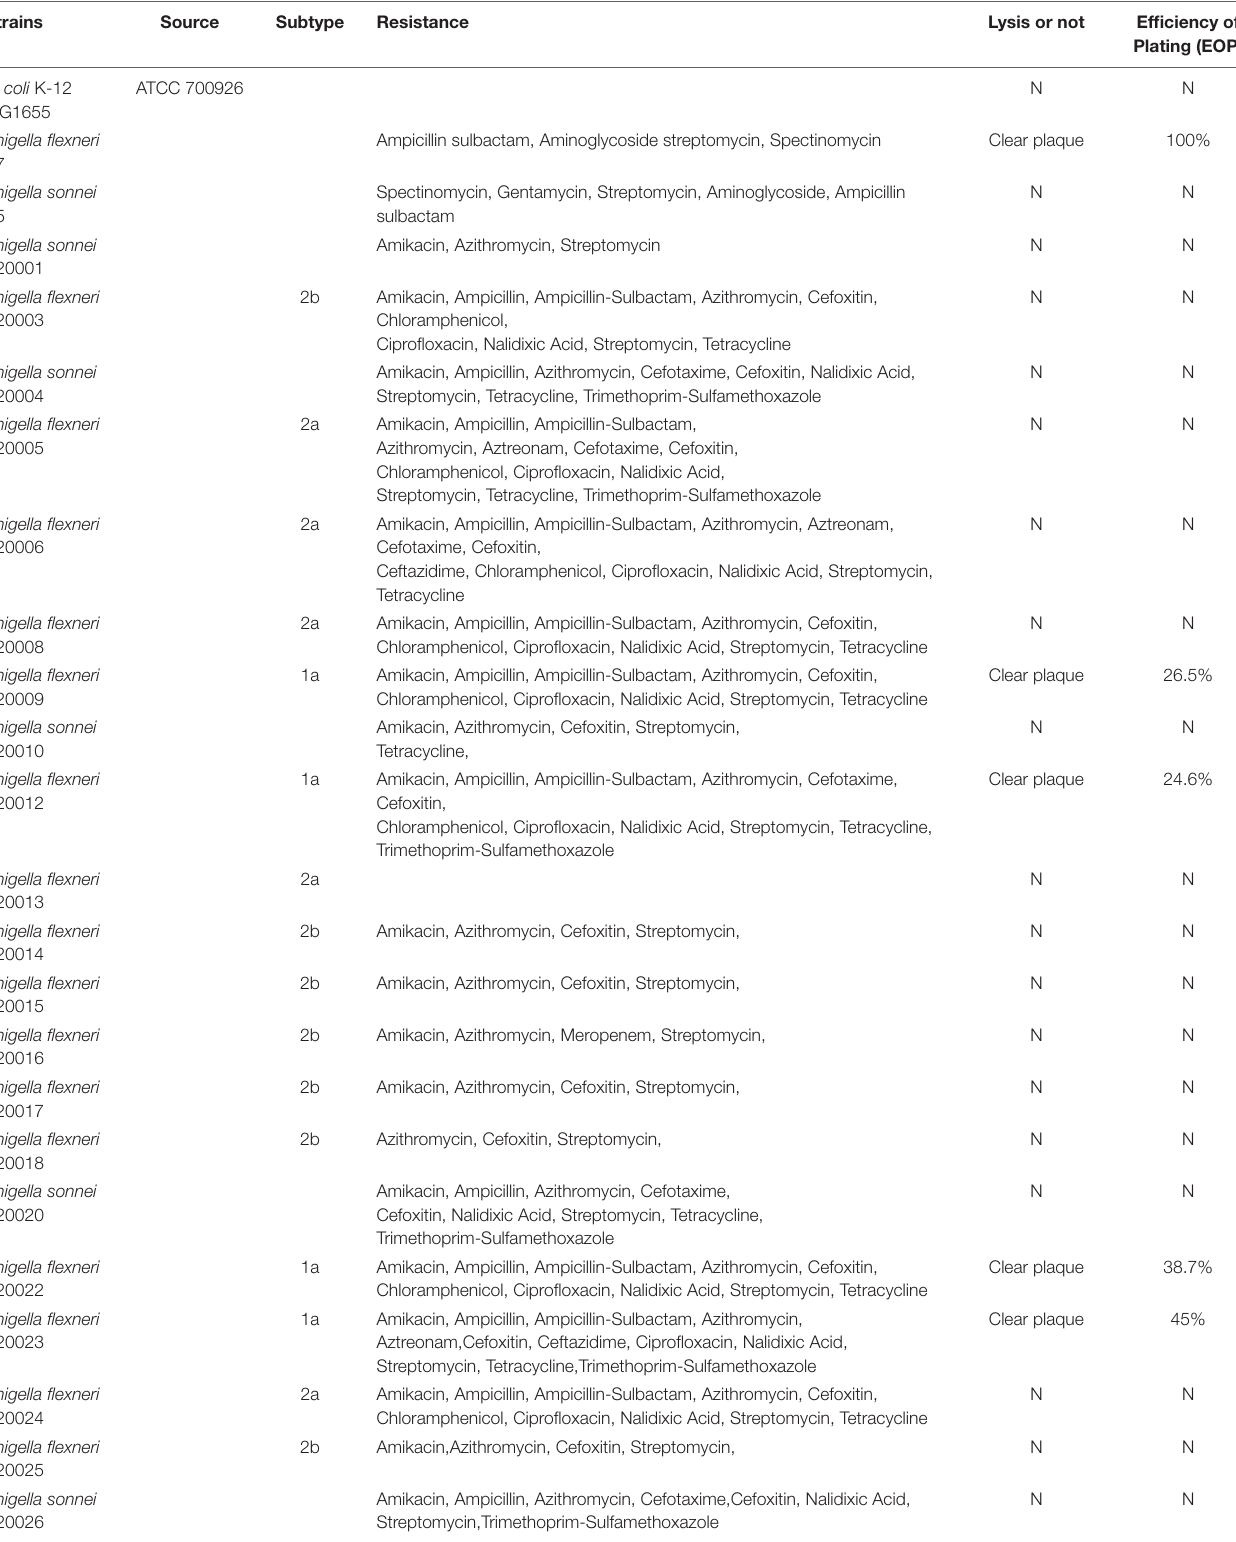
TABLE 1 | Host range spectrum of the bacteriophage vB_ShiP-A7.